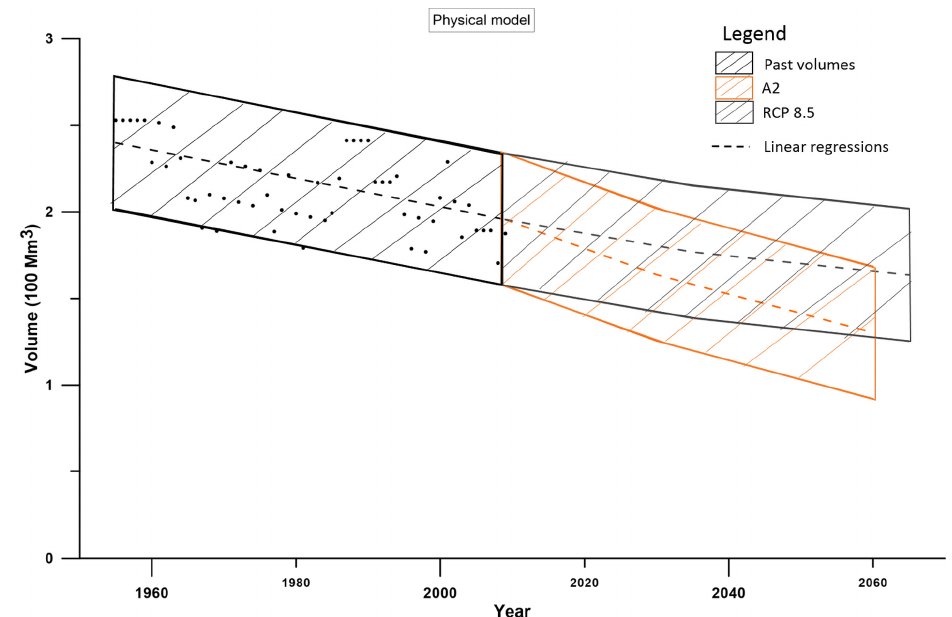
Figure 7. Graph, with the shaded areas representing the effective volume of Shela aquifer and projected volumes for A2 and RCP 8.5 climate change scenarios, as well as the